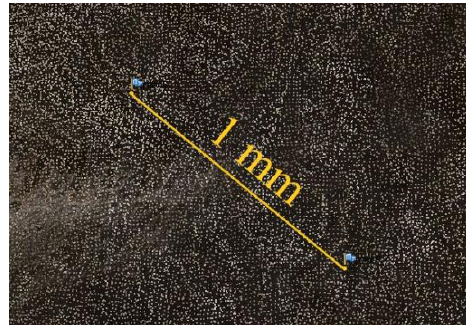
Figure 8. The 42 mln dense point cloud